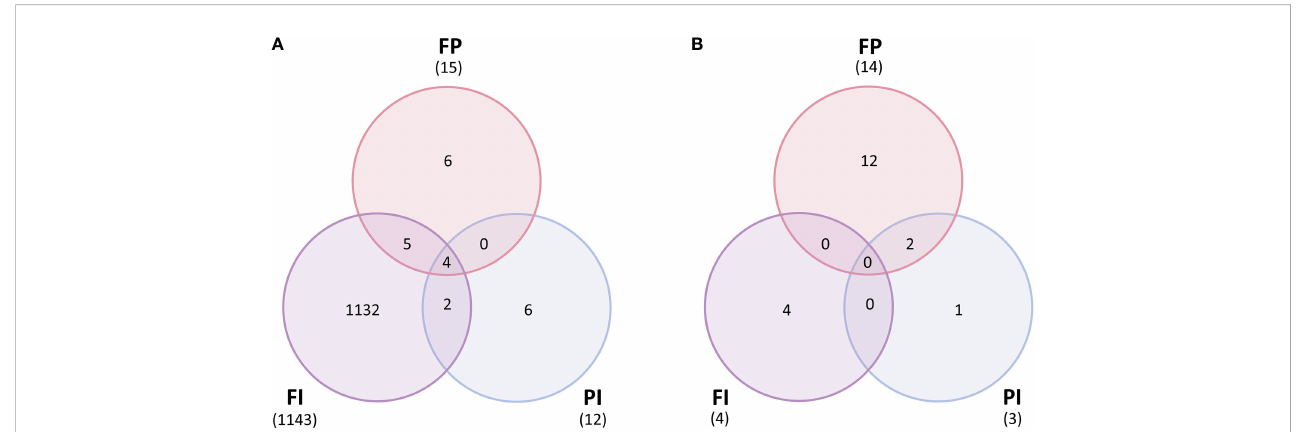
FIGURE 8 Differentially expressed genes between fi lter treatments and control. (A) Lettuce normalized gene expression (counts per million) contrasted between each treatment for each fi lter (FI, FP and PI) and the control (C) (p<1e-05). Lettuce grown under the FI fi lter had thousands of differentially expressed genes relative to the control, while the FP and PI treatments both had fewer than twenty DEGs each. (B) Tomato normalized gene expression (counts per million) contrasted between each treatment for each fi lter (FI, FP and PI) and the control (C) (p<1e-05). Very few genes were differentially expressed between each light treatment in tomato, with the majority found in the FP/C contrast.